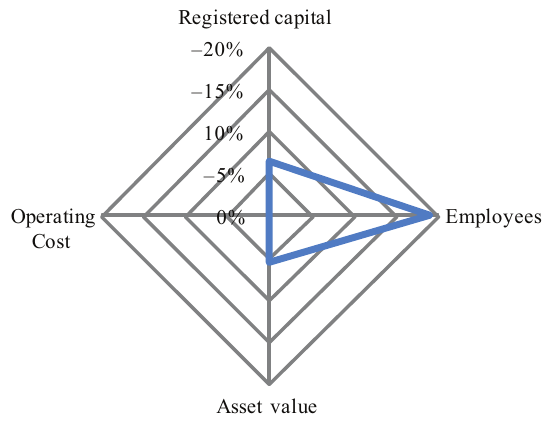
figure 5. Slack proportions of the inefficient